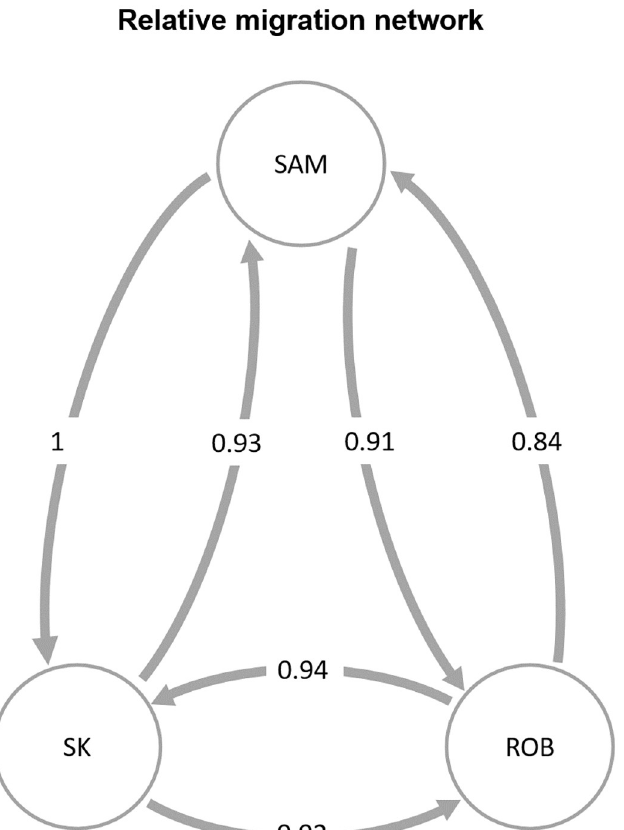
Fig 4. Migration network for the sampling sites of C . sylviae on Robinson Island (ROB), Selkirk Island (SK), and Sam Ambrosio Island (SAM). This figure was generated with the divMigrate function implemented in diveRsity (Keenan et al., 2013 [32]). Each vertex represents a sampling site, and each arrow represents the magnitude and direction of the relative migration.